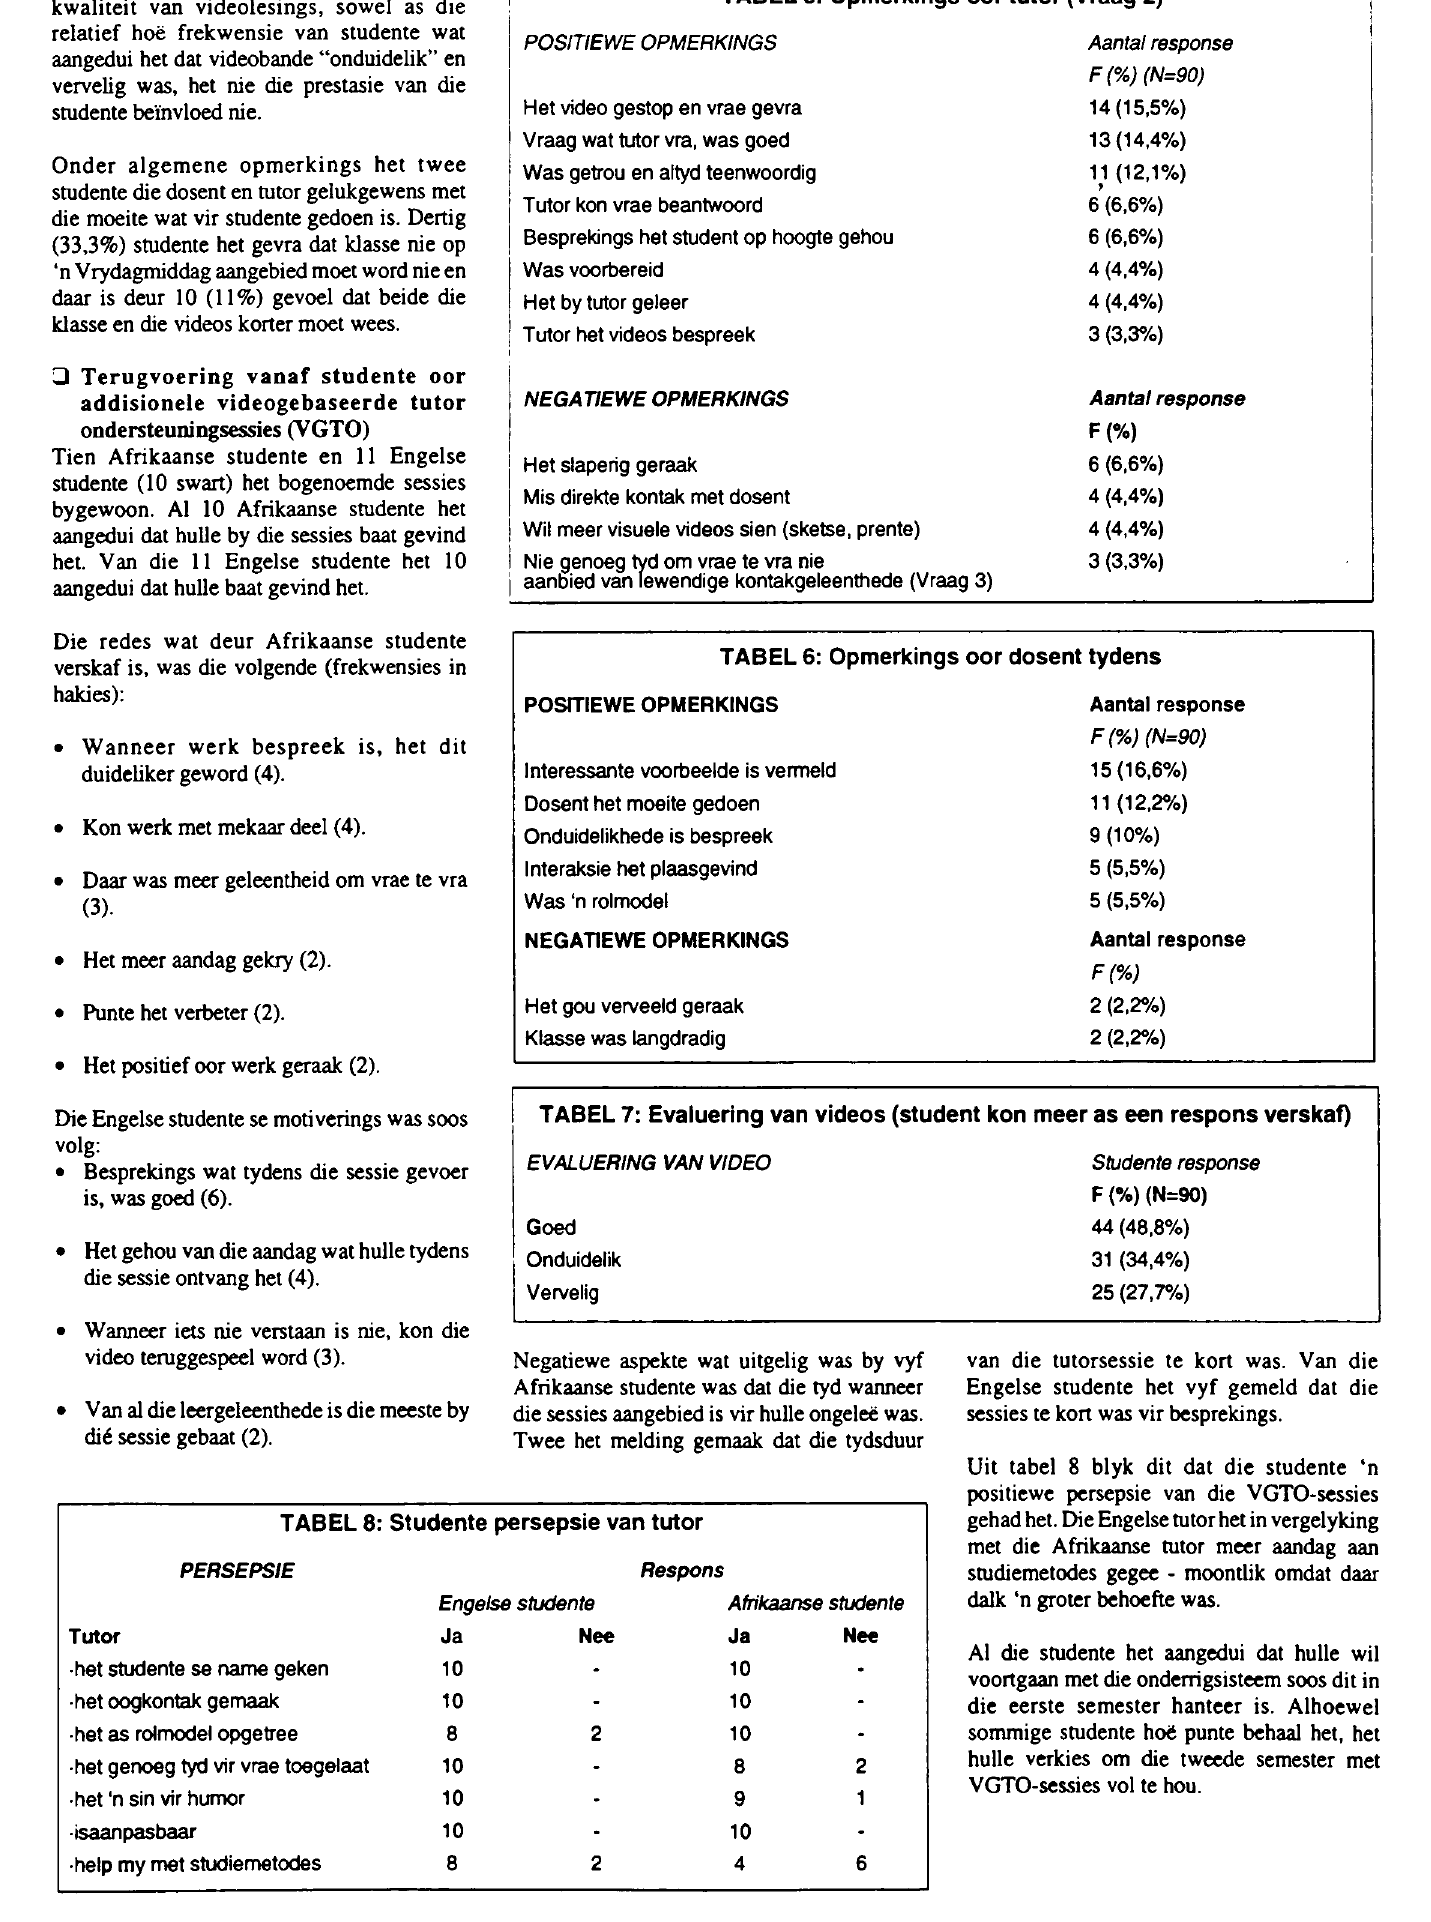
TABEL 6: Opmerkings oor dosent